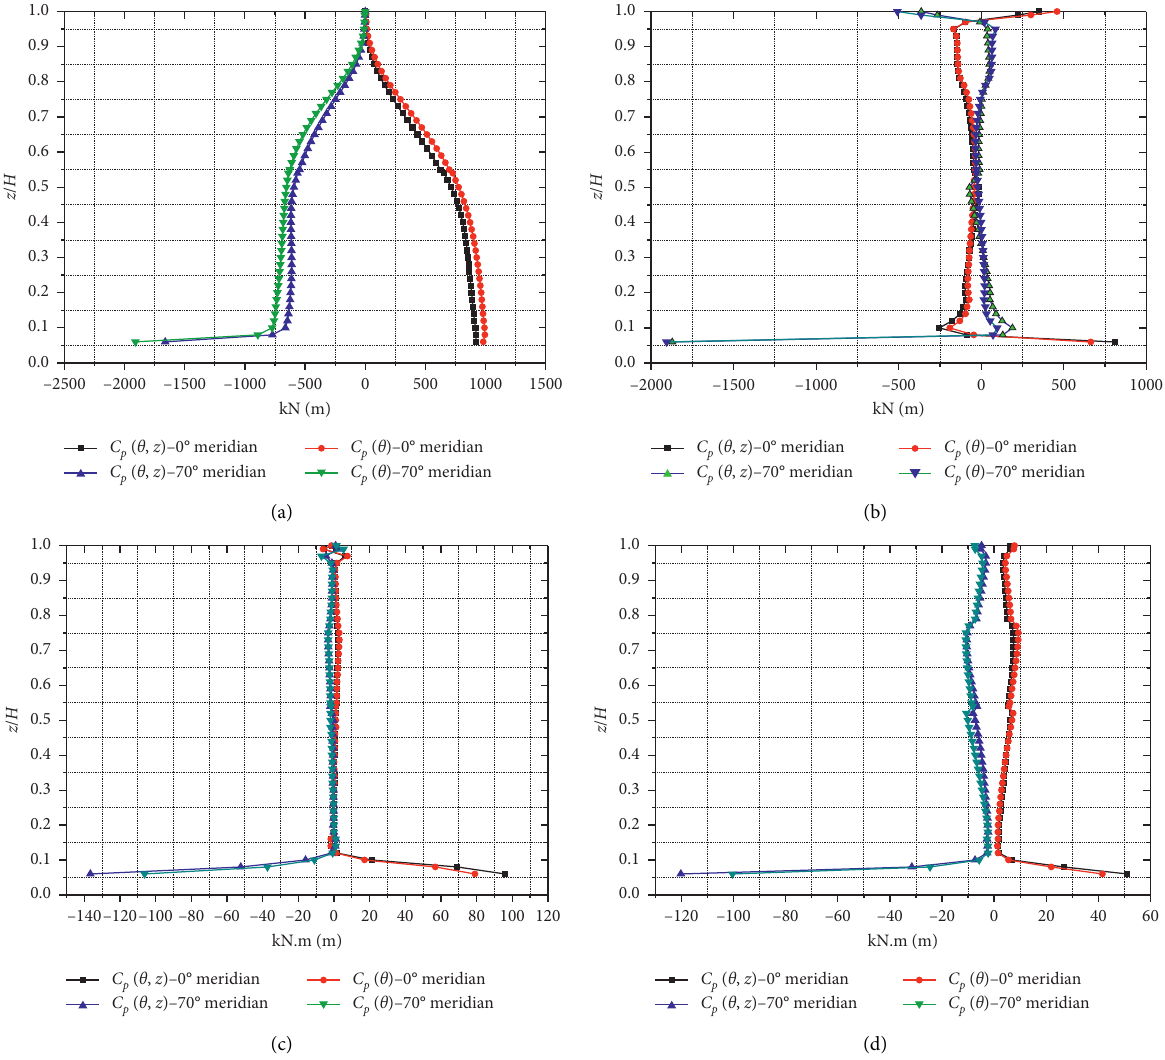
Figure 9: Comparison of membrane forces. (a) Meridional axial force. (b) Hoop axial force. (c) Meridional bending moment. (d) Hoop bending moment.